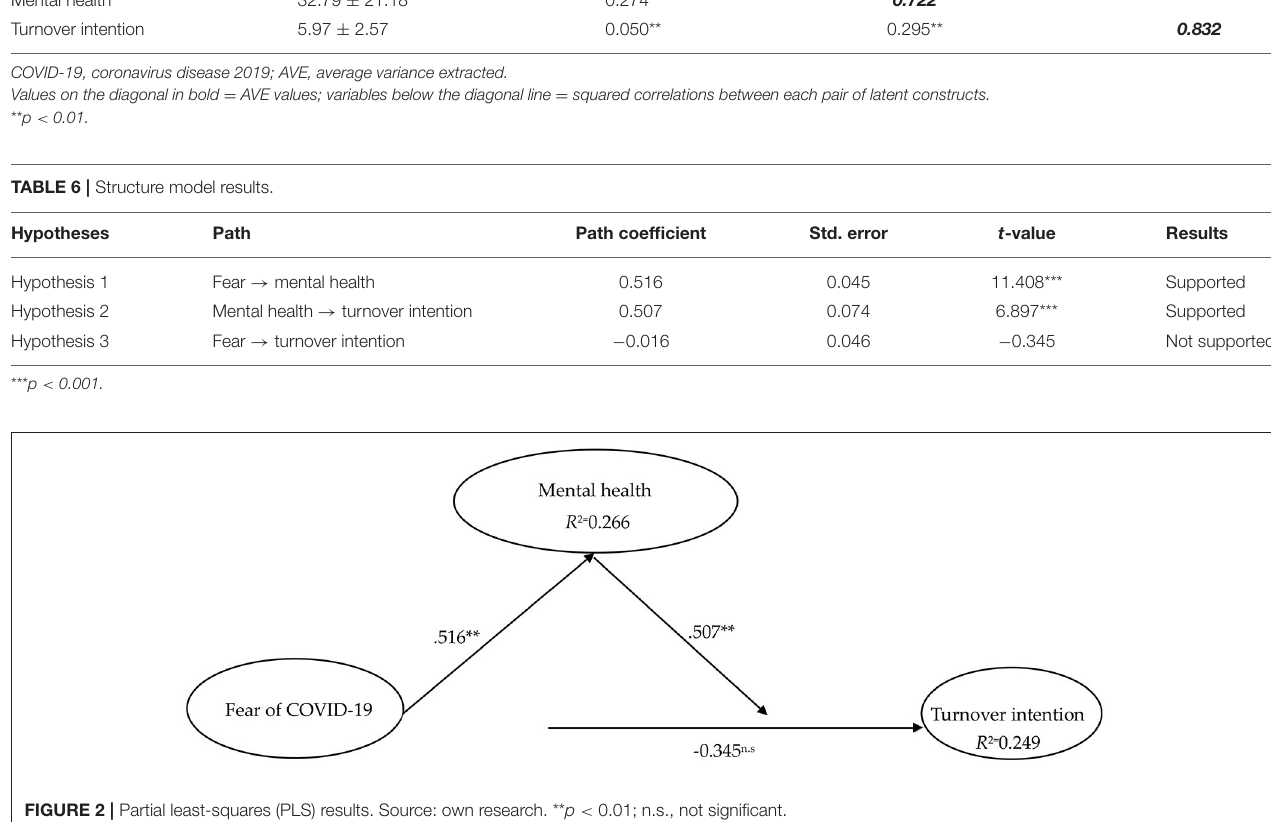
FIGURE 2 | Partial least-squares (PLS) results. Source: own research. ** p < 0.01; n.s., not